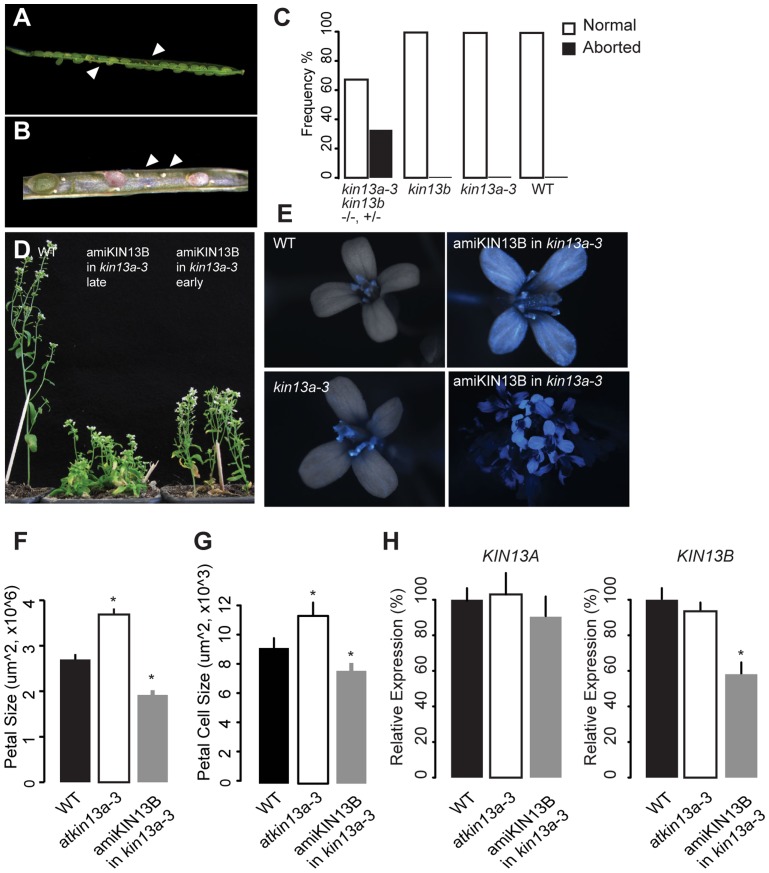
Redundant function of AtKIN13A and AtKIN13B.(A,B) Lower-magnification (A) and higher-magnification view of opened siliques of an atkin13a-3 +/atkin13a-3 atkin13b-1 plant to show seed abortion (arrowheads in (A)) and unfertilized ovules (arrows in (B)). (C) Quantification of seed abortion. Values are based on more than 100 seeds per genotype. (D) Whole-plant photographs of the indicated genotypes after EtOH-induction before (early) and during bolting (late). (E) Overlays of light and CFP fluorescence micrographs of flowers from the indicated genotypes after EtOH-induction. CFP fluorescence indicates expression of the amiRNA transgene. The two images on the right show a single flower and an overview of an inflorescence from an amiKIN13B-expressing atkin13a-3 mutant plant. (F) Petal sizes of indicated genotypes. Values are mean ±SD of 12 petals from more than 8 plants. (G) Petal-cell sizes of the indicted genotypes. Values are mean ± SD of 50 petal cells from more than 16 petals. (H) Relative expression of AtKIN13A (left) and AtKIN13B (right) in plants of the indicated genotypes after EtOH induction. Values are mean ± SD of three technical replicates. A biological replicate experiment is shown in Fig. S8D. Asterisk indicates significant difference from wild-type at p<0.05 (with Bonferroni correction).